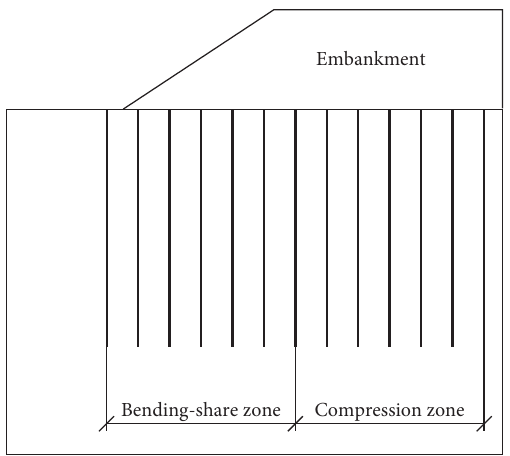
Figure 1: Different zones of